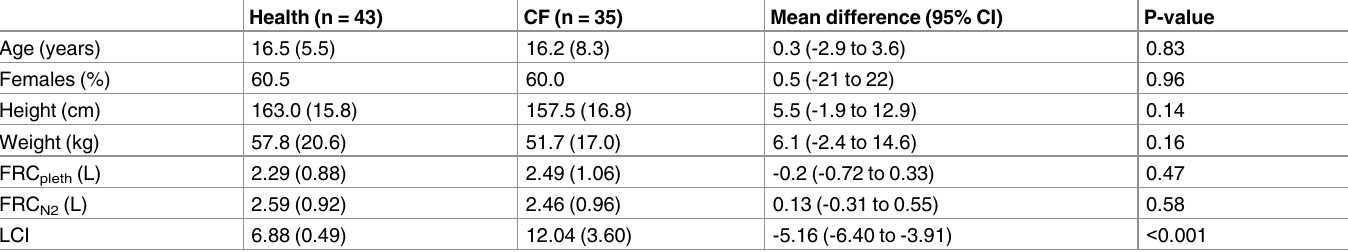
Table 2. Characteristics of study participants. Values are presentedas mean (SD) unless otherwiseindicated. P value indicatesgroup difference betweenhealth and